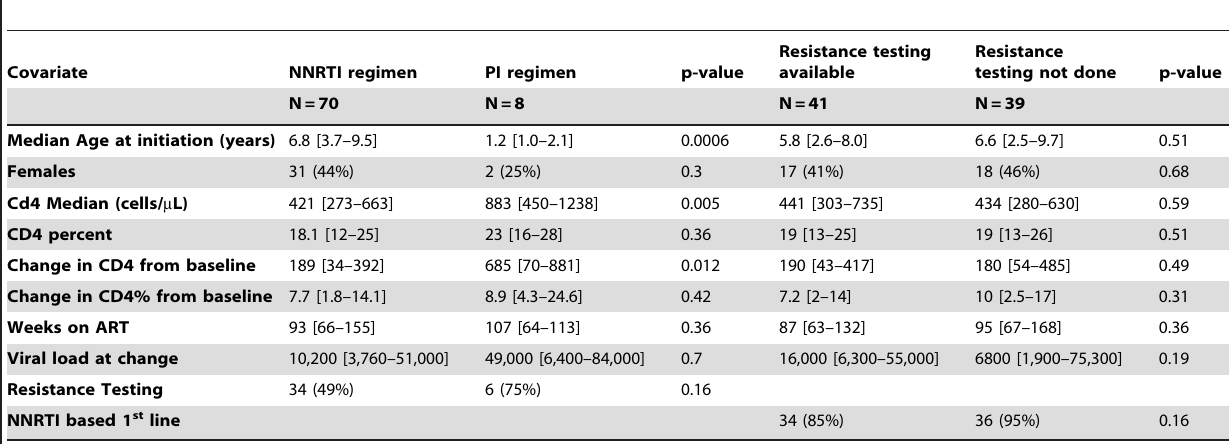
Table 1. Baseline Clinical and Demographics Characteristics of A Cohort of HIV-Infected Children Failing 1 st Line ART in Durban, South Africa Stratified by Initial Treatment Regimen and Presence of Resistance Testing.